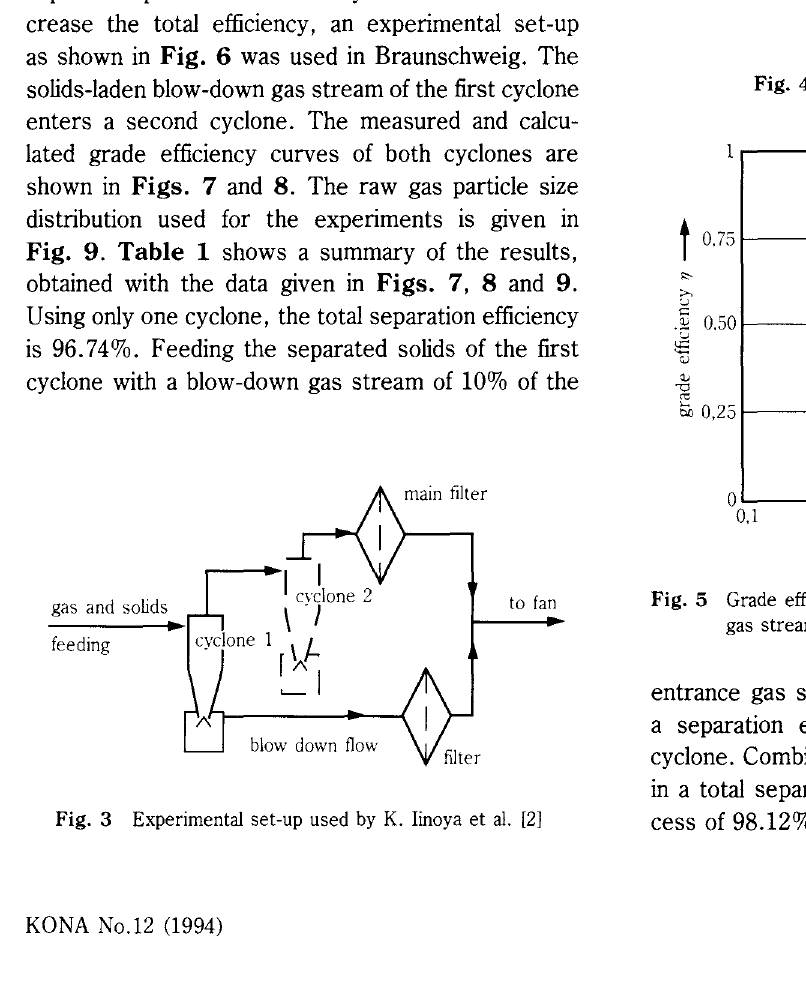
Fig. 4 Cyclone used as a classifier [2]